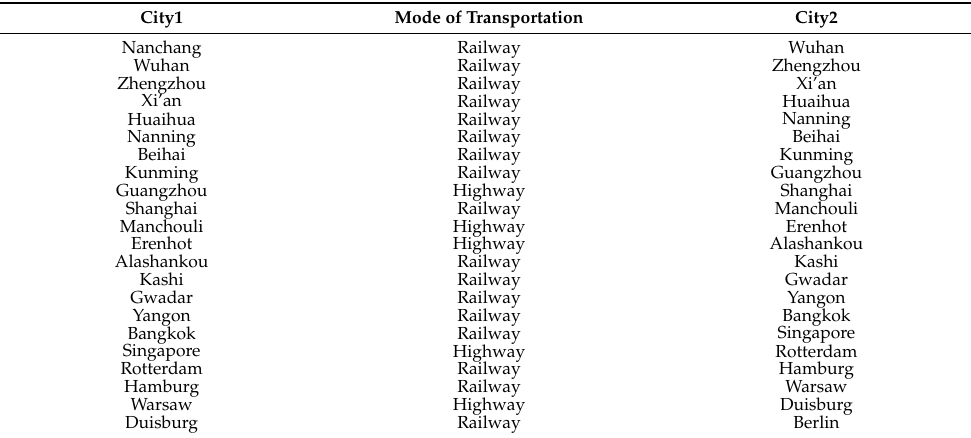
Figure 15. EGA algorithm to optimize multimodal transport network from Nanchang to Berlin. Table 9. EGA algorithm optimizes the optimal path of multimodal